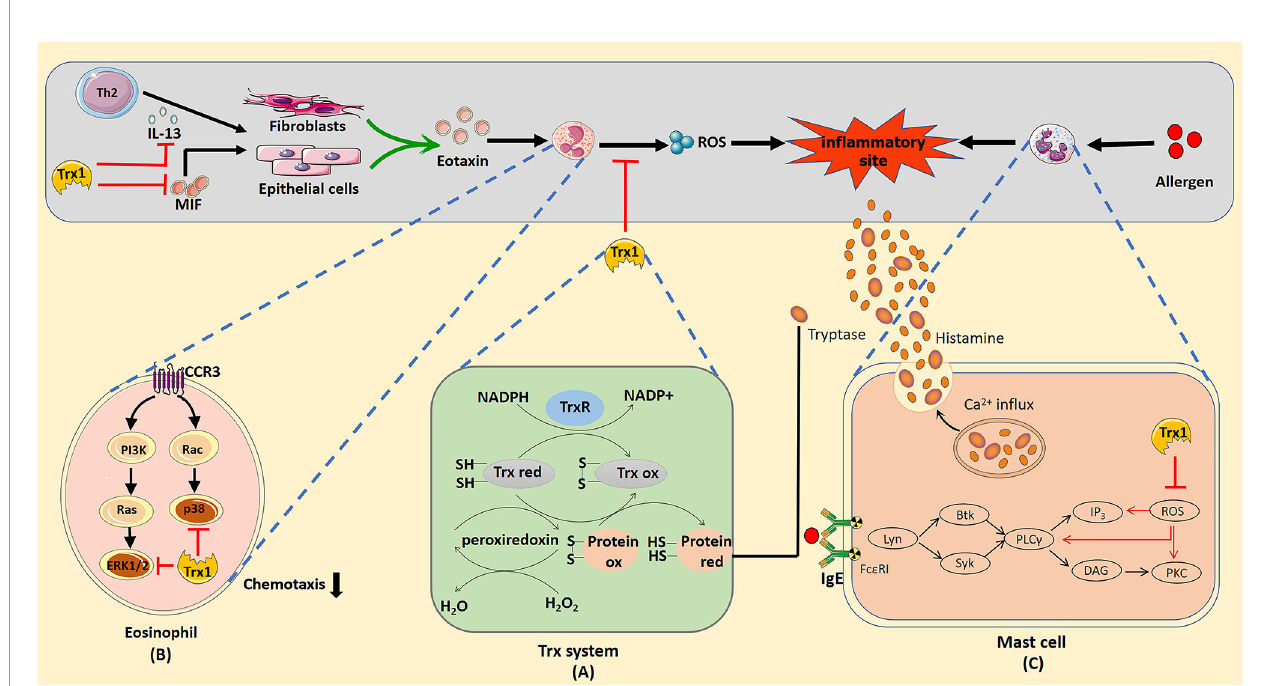
FIGURE 1 | (A) Mechanism of redox regulation by the thioredoxin (Trx) system. The reduced form of Trx catalyzes the reduction of the disulphide bonds in the target protein. Oxidized thioredoxin is restored to its reduced state by the NADPH-dependent fl avoenzyme thioredoxin reductase. (B) Trx1 inhibition of eosinophil activation and chemotaxis. Trx1 can eliminate reactive oxygen species (ROS) produced by eosinophils and directly inhibit the activation of the mitogen-activated protein kinase signal pathway when entering cells. Trx1 regulates Th2 response by inhibiting IL-13 production, which prevents IL-13 from stimulating epithelial cells or fi broblasts to produce eotaxin. In addition, Trx1 blocks the pro-in fl ammatory effect of the upstream chemokine macrophage migration inhibitory factor, which can directly induce the chemotaxis of eosinophils or promote the production of eotaxin by epithelial cells or fi broblasts to promote eosinophil recruitment. (C) Potential mechanisms of the effects of Trx1 on mast cell degranulation. Crosslinking of the allergen and IgE complex with Fc ϵ RI activates the mast cell degranulation pathway, which then activates Lyn, Syk, Btk, and phospholipase C g (PLC g ). Activation of PLC g eventually activates Ca 2+ and protein kinase c (PKC), which contributes to degranulation. ROS induced in Fc ϵ RI-stimulated mast cells activate mast cells by activating PLC g , Ca 2+ in fl ux, and PKC. Accordingly, Trx1 prevents mast cell degranulation by scavenging ROS. The effective catalytic function of b II tryptase secreted by mast cells depends on the existence of normal disulphide bonds in molecules. The Trx1 system selectively reduces the number of disulphide bonds, which then reduces the catalytic activity of b